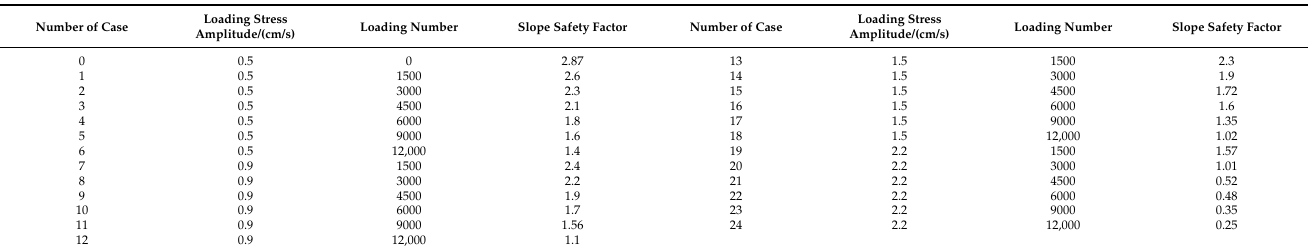
Figure 11. Change of slope safety factor. Table 2. Change of slope safety factor under different loading number and different loading stress amplitude.